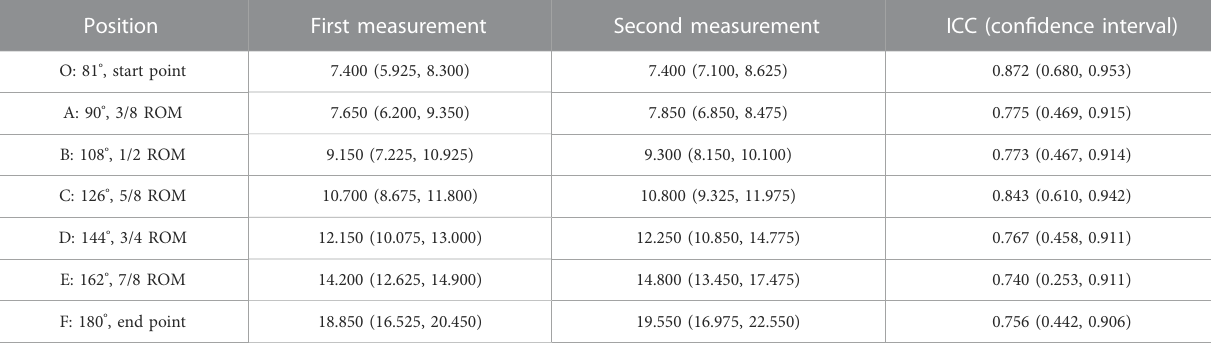
TABLE 3 Repeatability of Young ’ s modulus measurement at each elbow position.